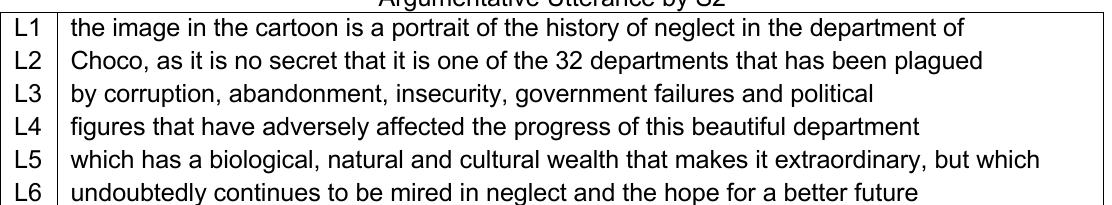
Argumentative Utterance by